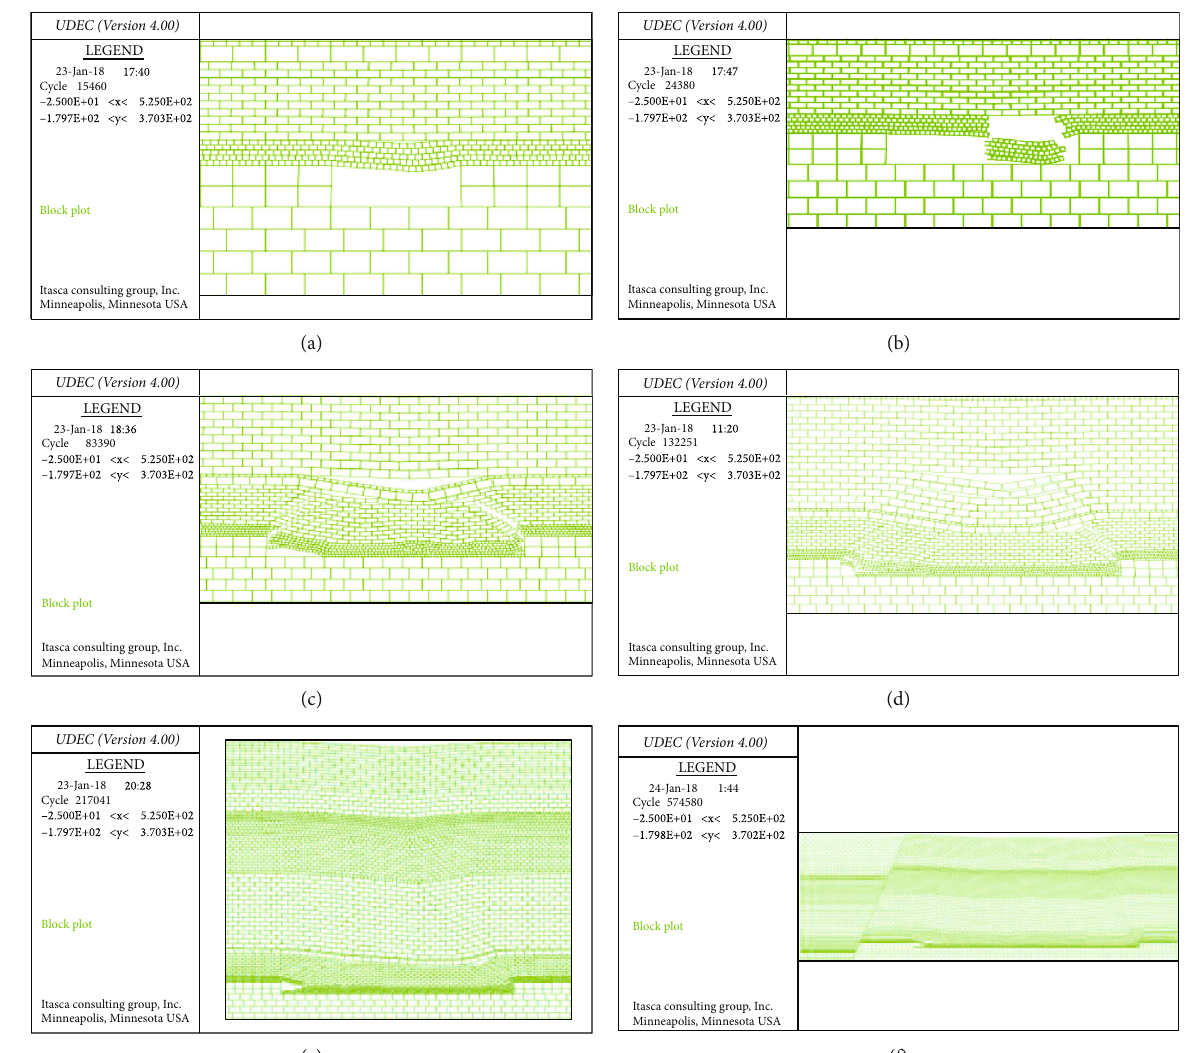
Figure 4: The migration change map of overlying strata under di ff erent distances of working face advancing, including (a) 10m, (b) 30 m, (c) 70m, (d) 95m, (e) 120m, and (f) 300